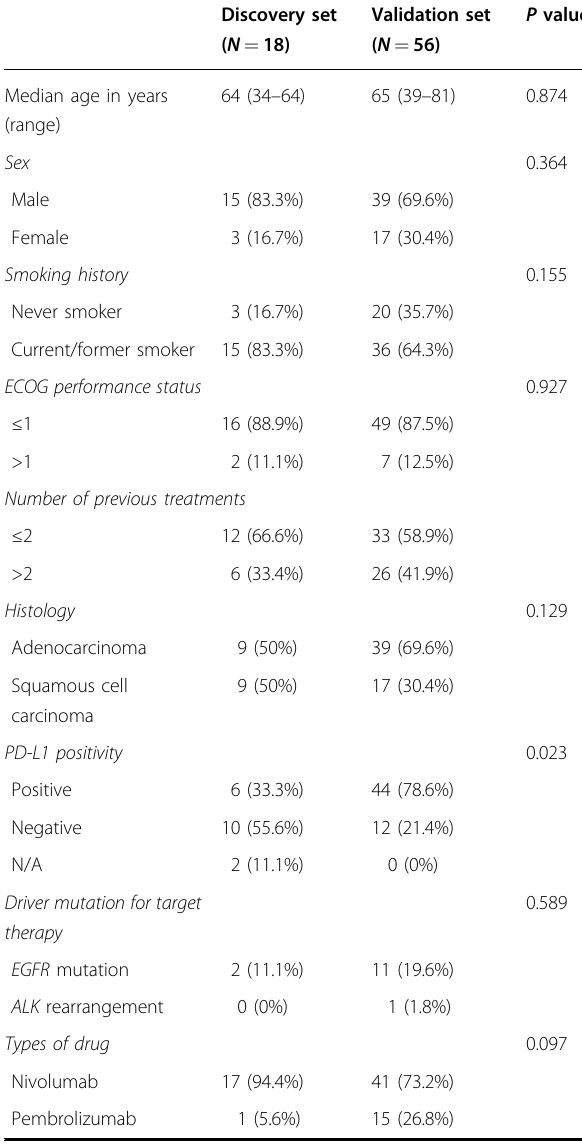
Table 1 Baseline clinicopathological